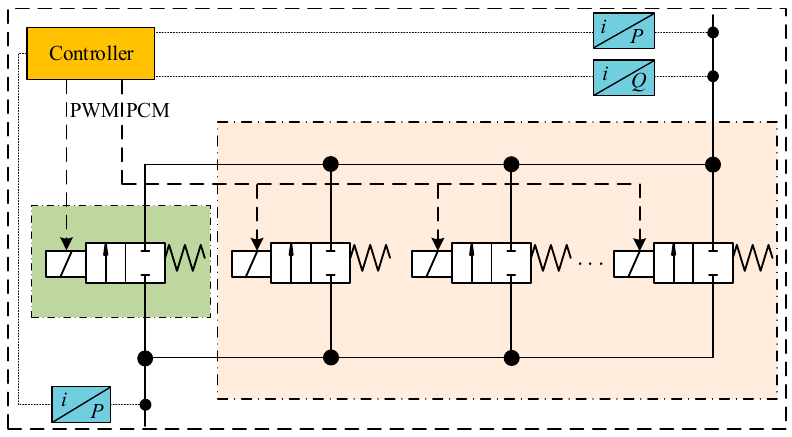
Figure 14. Digital valve group driven by PWM and PCM.